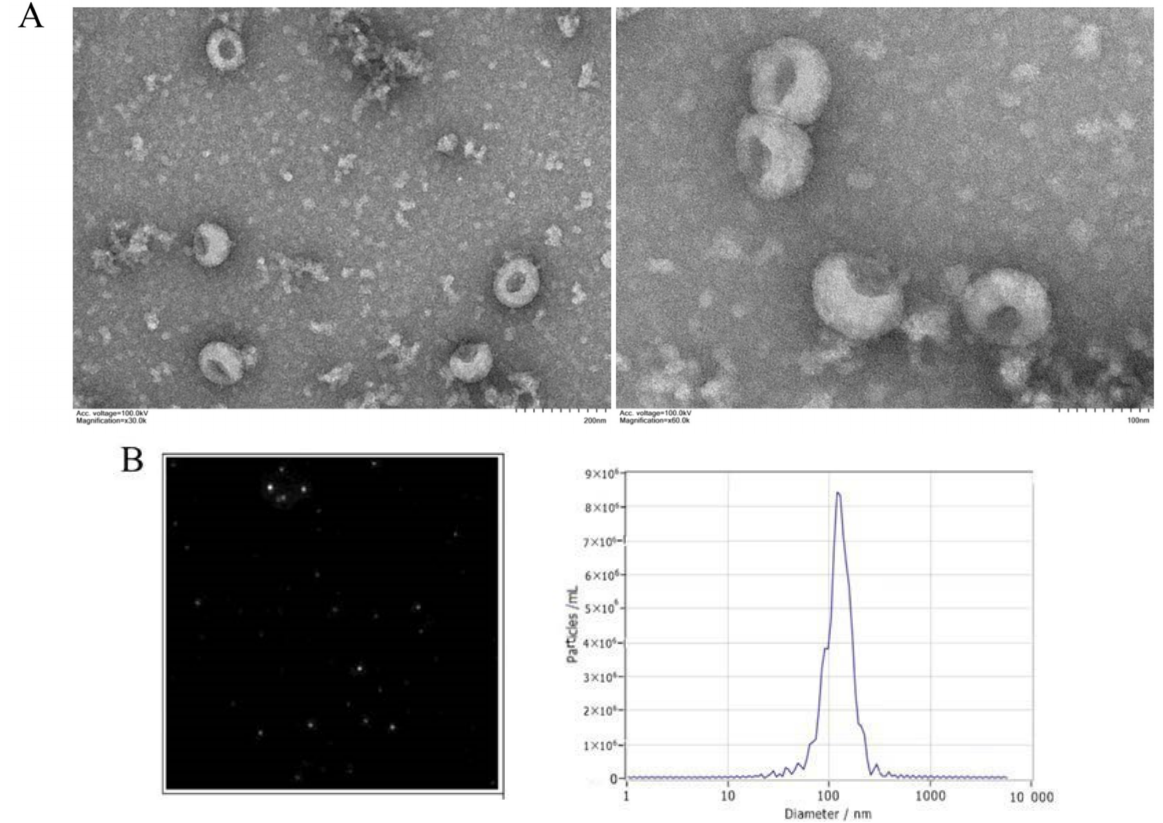
Figure 1. Characterization of Vero cell-derived exosomes. Exosomes were isolated and purified from PEDV-uninfected and -infected Vero cell culture. ( A ) Morphology of exosomes observed by TEM. Scale bars, 100 nm and 200 nm. ( B ) Particle size and quantification analysis of exosomes by NTA.